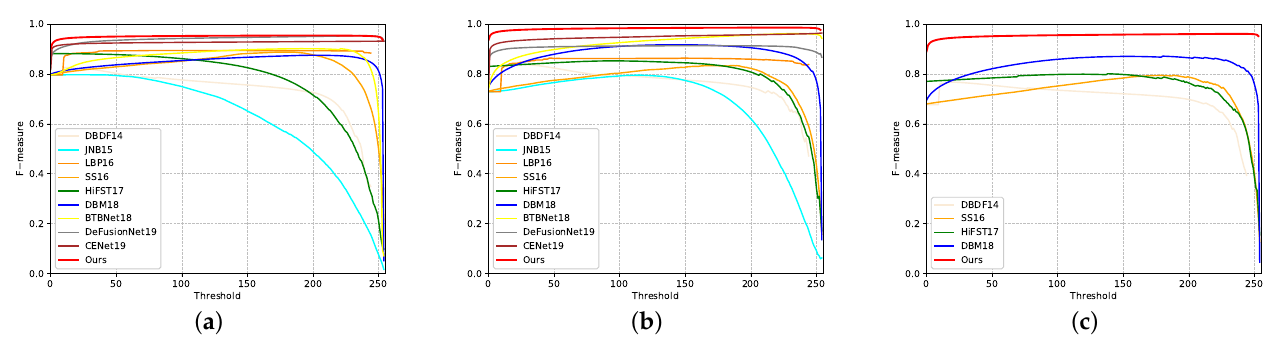
Figure 6. Comparison of F √ -measure curves of different methods on three test sets. The curves of our method are the 0.3 highest curves on the three test sets. ( a ) DUT test set; ( b ) CUHK ∗ test set(without motion blurred images); ( c ) CUHK test set